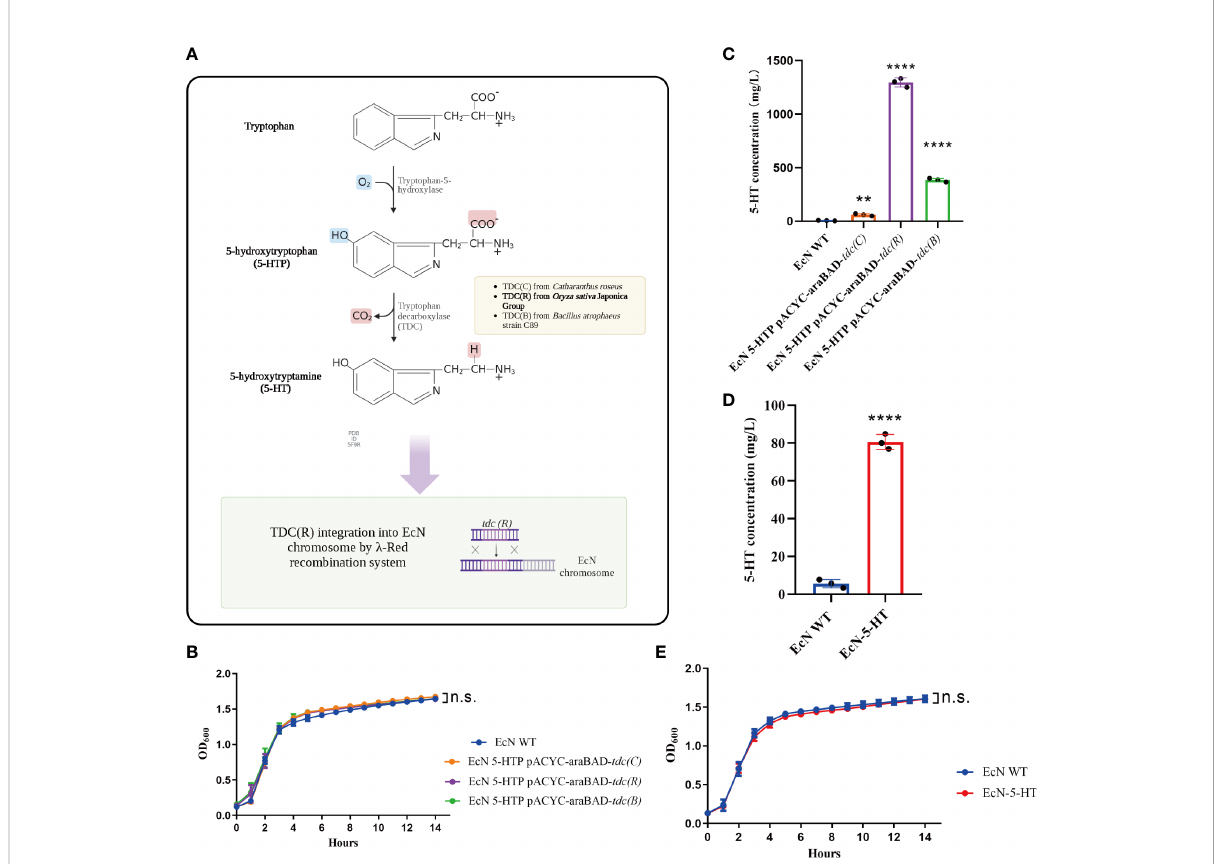
FIGURE 1 Engineer Escherichia coli Nissle 1917 (EcN) to synthesis of human neurotransmitter 5-HT. (A) Schematic summarizing the design strategy to engineer EcN-5-HT. (B) Growth curve of the three engineered EcN in LB medium. (C, D) Measurement of 5-HT production by UPLC-MS/MS. (E) Growth curve of the engineered EcN-5-HT in LB medium. Mean values ± SDs are presented, p values were calculated using unpaired t-test, **p < 0.01, ****p < 0.0001, n.s: not signi fi cant. Data are pooled from three independent experiments with n = 3 per